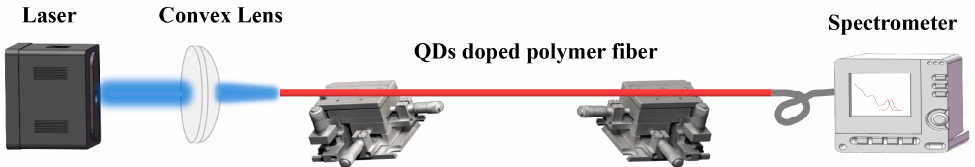
Figure 2. Schematic diagram of spectral